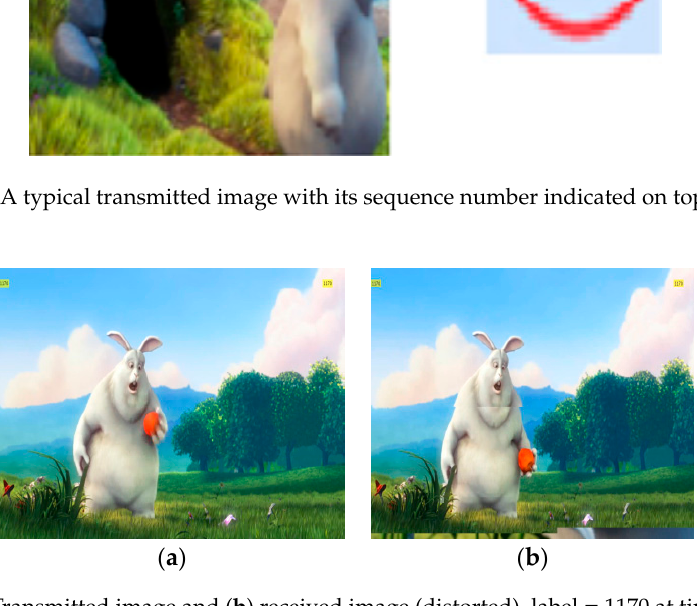
Figure 8. ( a ) Transmitted image and ( b ) received image (distorted), label = 1170 at time 65 second.